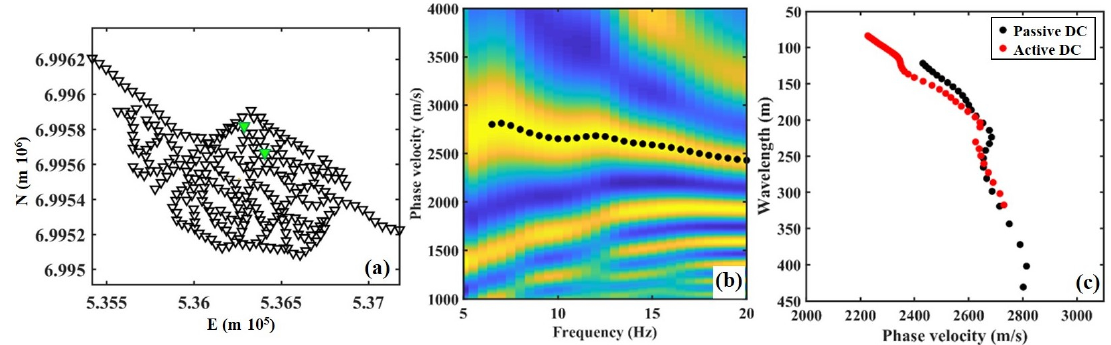
Figure 5. Example of DCs obtained by the two-station method. (a) Network geometry and considered receiver pair (green triangles). (b) Stacked cross-multiplication matrix and picked passive DC (black dots). (c) Comparison between passive and active DCs for the same receiver couple.